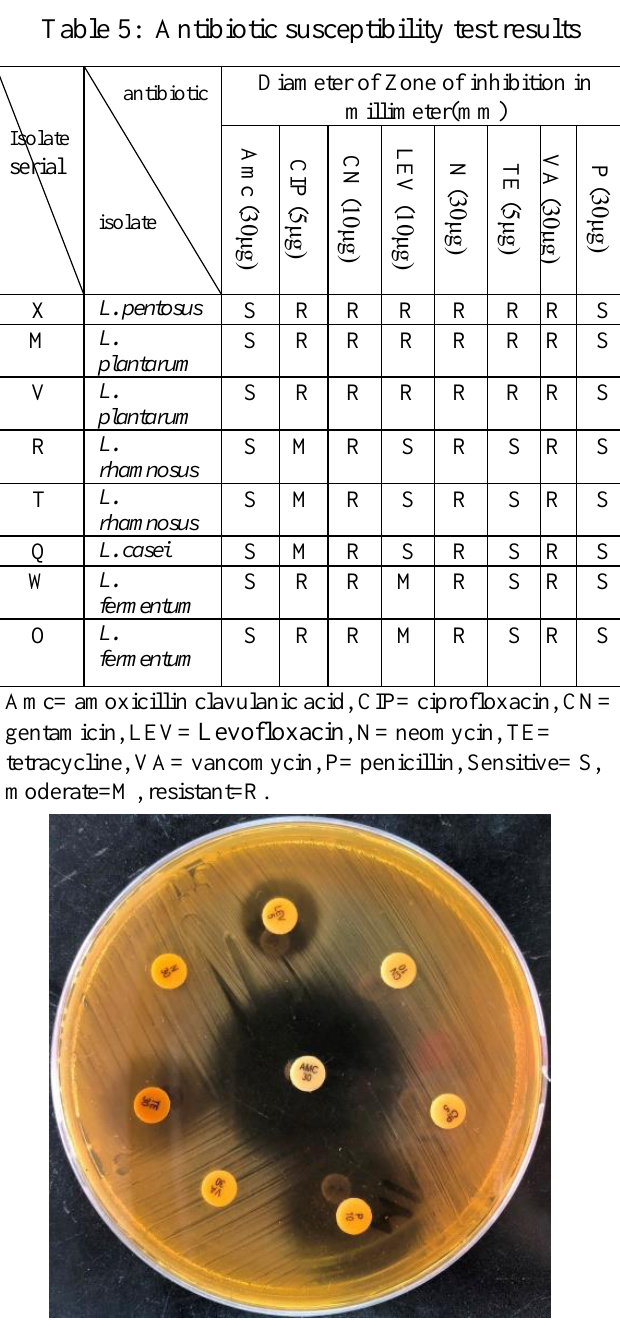
Fig. 7: Antibiotic susceptibility test for L. plantarum , Inhibition zones around antibiotic